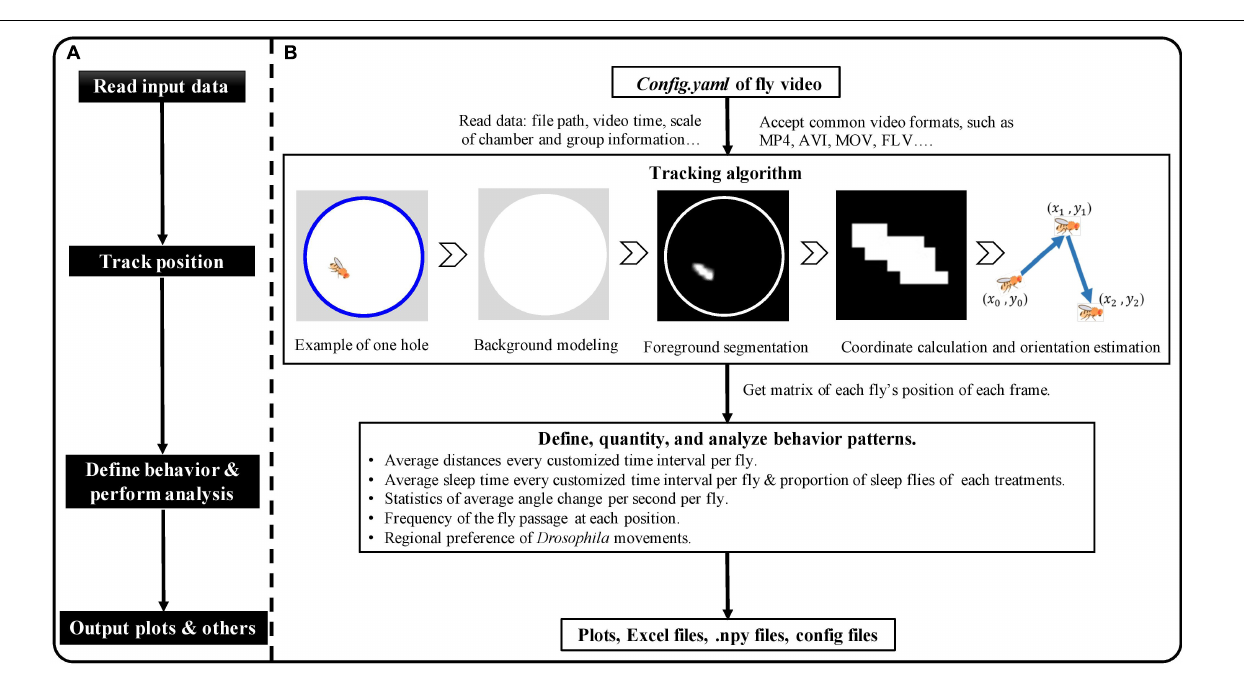
FIGURE 2 | The schematic plot of EasyFlyTracker. (A) General flow of the software. (B) Details of input data, tracking algorithm, behavior definition, output, and